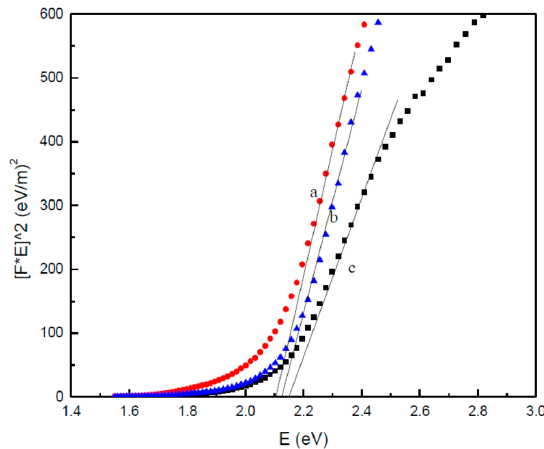
Figure 6. The method of extracting the band gaps of CdO nanoparticles at PVP different concentration of ( a ) 0.03, ( b ) 0.04, and ( c ) 0.05 g/mL.